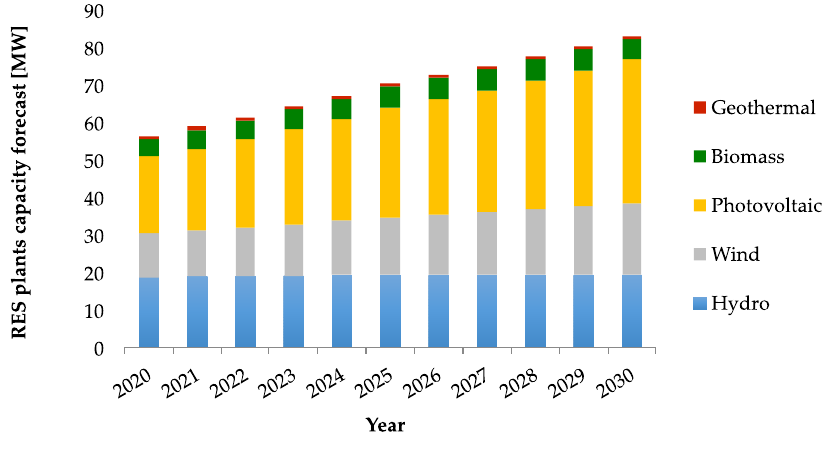
Figure 8. Renewable power capacity forecast trend [60].